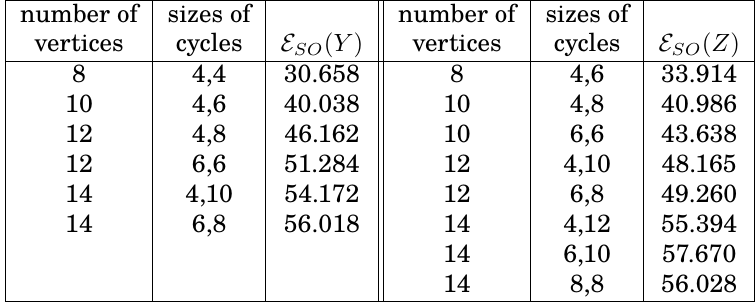
Table 2: Sombor energies of bicyclic graphs Y a,b and Z a,b whose structure is found in Figure 1. A H¨uckel-rule-type dependence can be envisaged, but is somewhat less pronounced than in the case of X a,b . number of sizes of number of ( Y vertices E SO